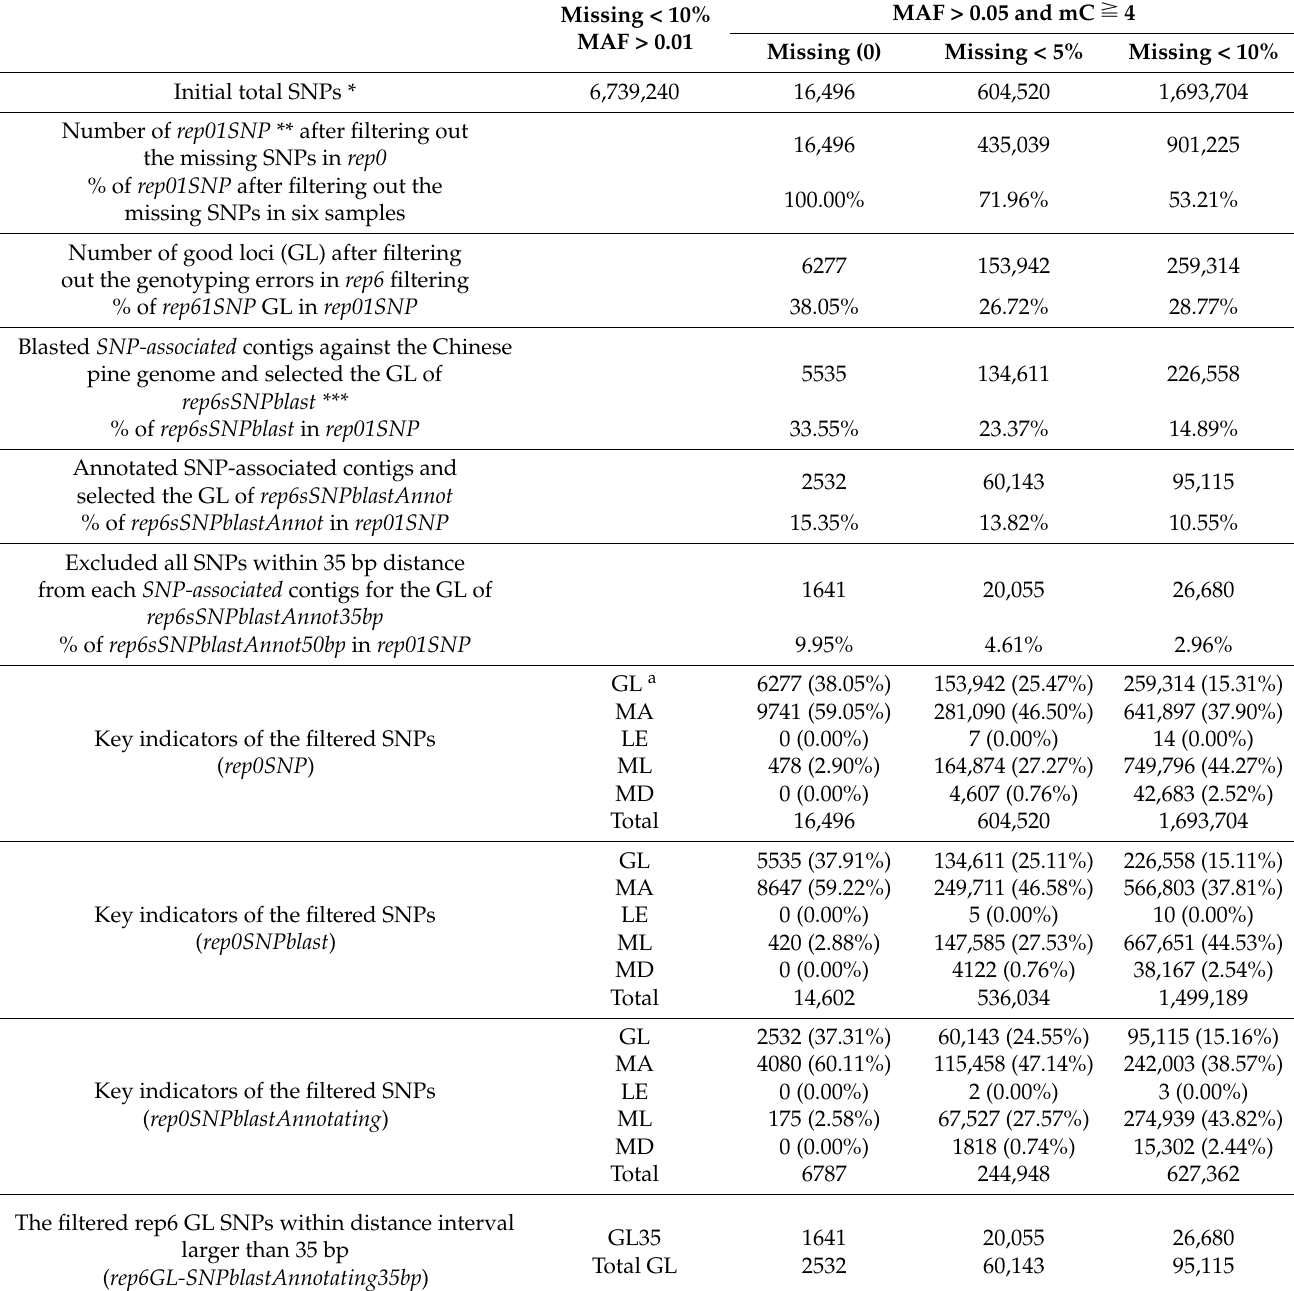
Table 4. The SNP counts and each key indicator genotyping error count for different missing levels in QC